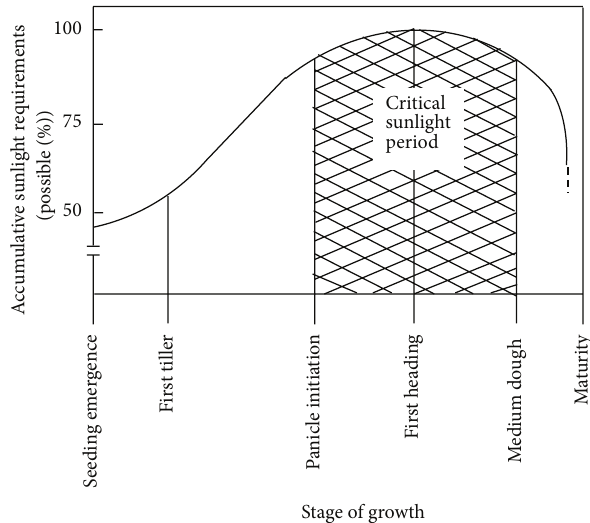
Figure 7: Solar radiation requirements of rice at different stages of growth and development (adapted from Stansel